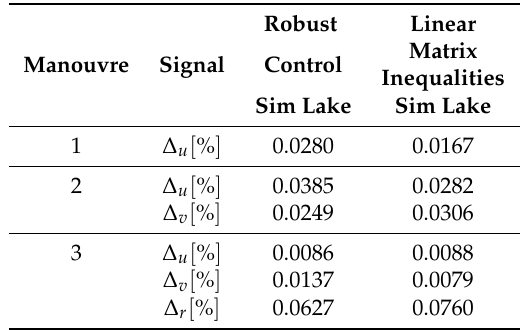
Table 3. Comparison of mean deviation from given values describe in (34).